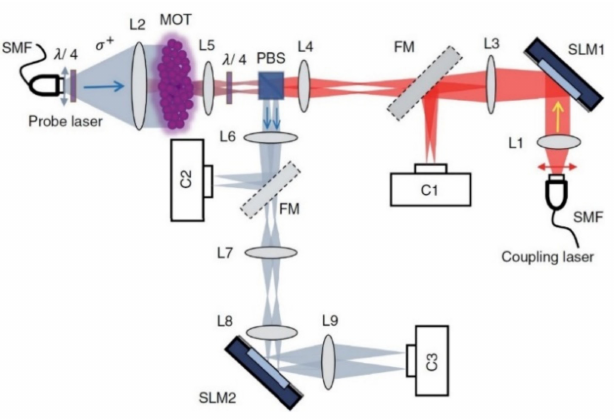
Figure 3. Implementation of the all-optical neural network (AONN) based on free optics [54].